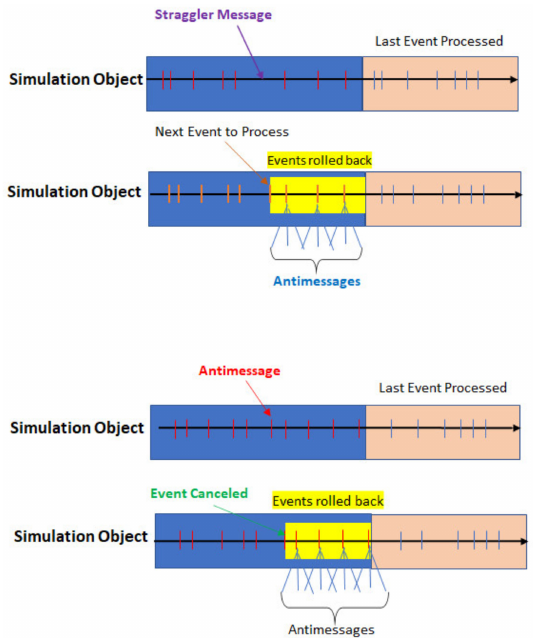
Figure 2. The implementation of rollback produced by straggler messages and antimessages in time warp